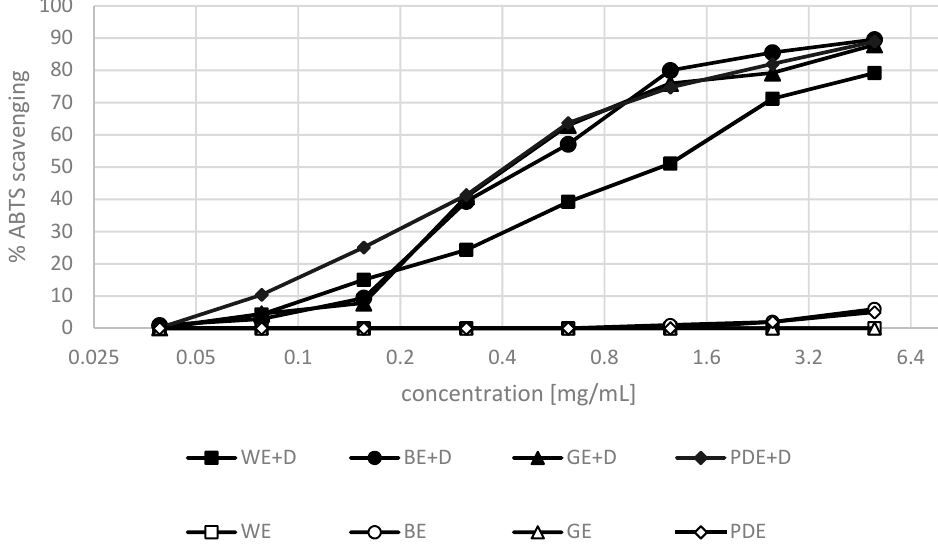
Figure 4. Analysis of antioxidant properties (ABTS methods) in samples of extractants (WE—water, BE—water/betaine, GE—glycerin/betaine, PDE—propanediol/water) and extracts from dogwood fruits (WE+D—water extract, BE+D—water/betaine extract, GE+D—water/glycerin extract, PDE+D—water/propanediol extract) averaged from 3 measurements.